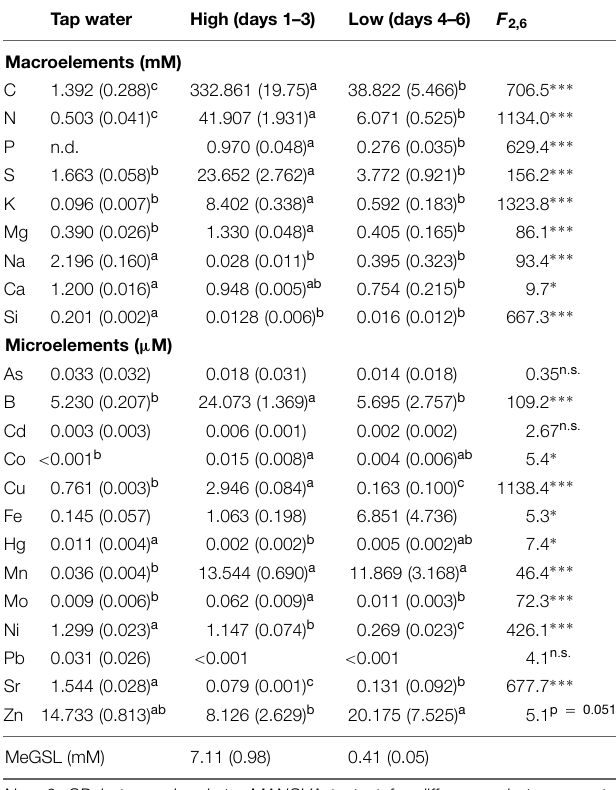
TABLE 2 | Elemental composition (macro elements, concentration in mM, micro elements: concentration in µ M, MeGSL in mM) of tap water, waste water of days 1–3 (High) or of days 4–6 (Low) collected during the soaking of Hanza ( Boscia senegalensis